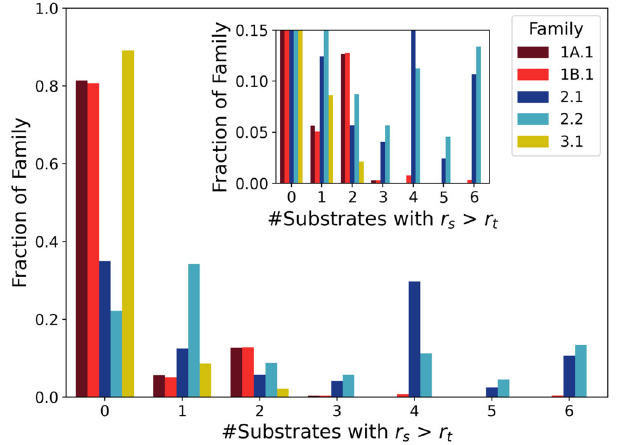
Fig. 5 Activity on multiple substrates and co-option potential. The frequency distribution of the fraction of unique sequences in each family ( y -axis) that is active on a given number of substrates ( x -axis). Activity on 2 or more substrates indicates potential for co-option. While Motif 2 sequences (Families 2.1 and 2.2) show a higher abundance of sequences active on more substrates, all families possess some sequences with activity on multiple substrates. Inset shows an enlargement of the low y -value region of the plot. Source data are provided as a Source Data fi le.